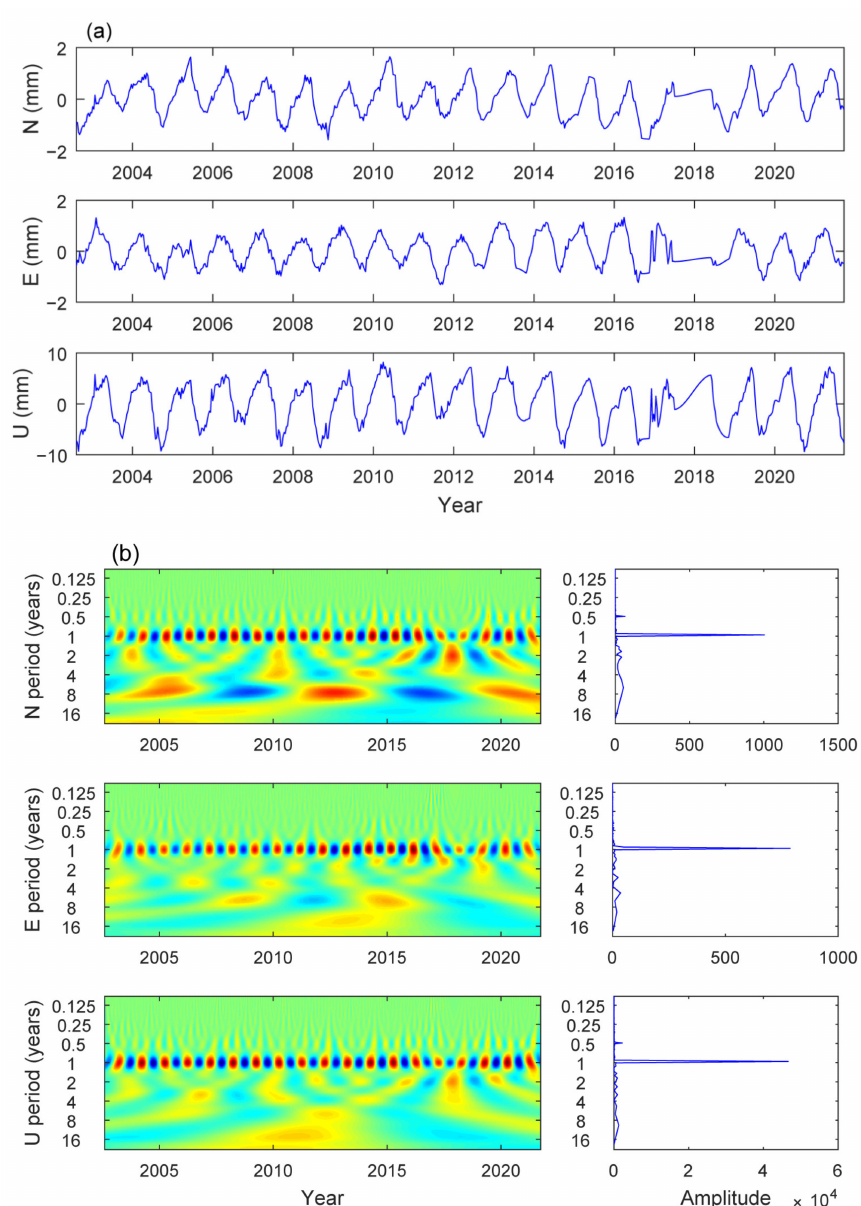
Figure 4. GRACE time series analysis of SCPZ station. ( a ) Time series. ( b ) Morlet wavelet transform ( left ), where red means peak and blue means trough; and its spectrum ( right